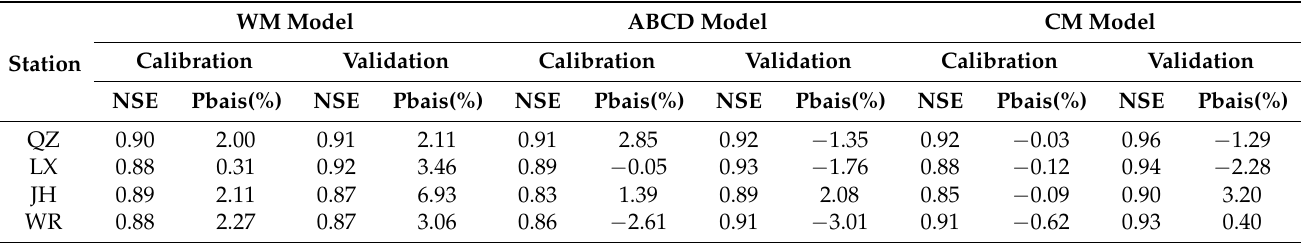
Table 3. Comparison of the three models’ simulation results for each watershed using observed rainfall